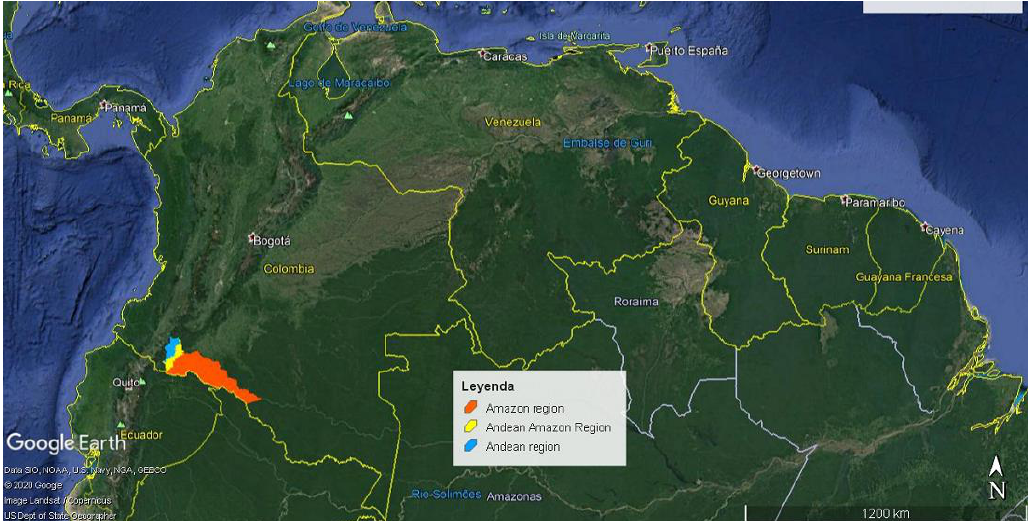
Figure 3. Location of IDEAM’s weather stations with sunshine data in the department of Putumayo. Table 1. IDEAM stations with solar brightness data in the department of Putumayo.